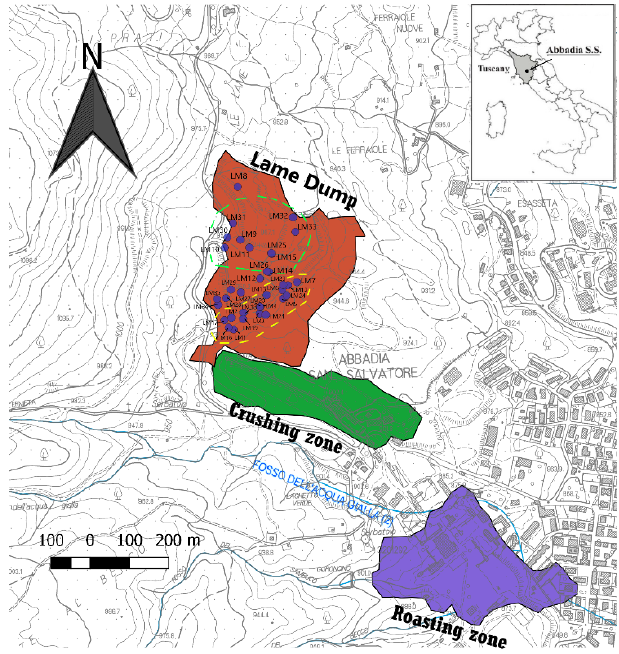
Figure 2. The study area of Le Lame (in orange) and the crushing (in green) and roasting (in purple) zones (modified after [1]). The purple dots refer to the soil samples collected for the present study. The yellow and pale-green dashed lines are probably defining the areas where the post-roasting processes by the Gould and Cermak-Spirek furnace were located, respectively.